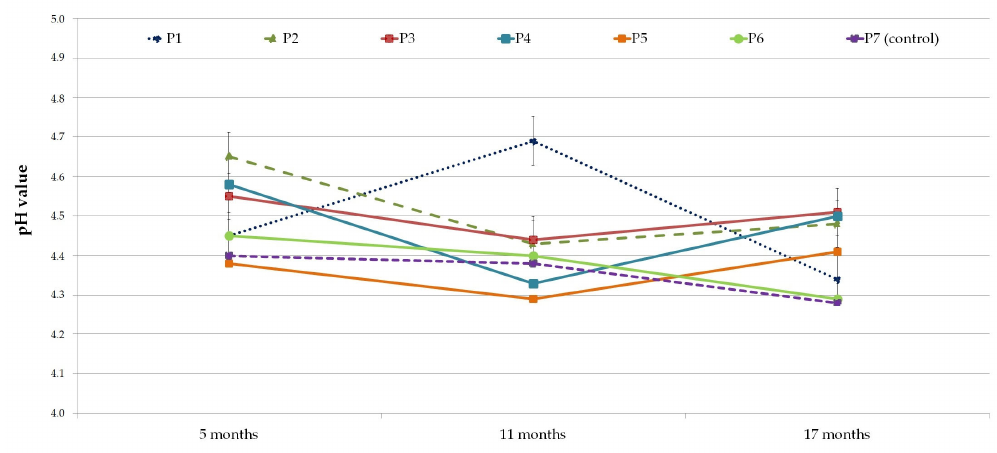
Figure 5. Silage pH value changes upon storage for 5, 11 and 17 months.